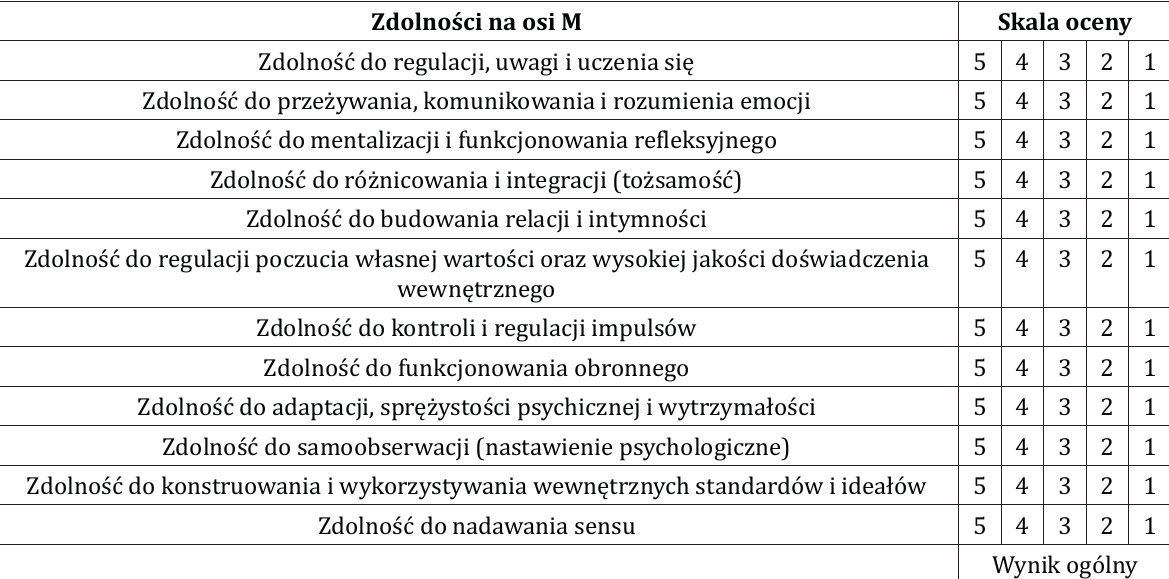
Tabela 2. Ocena zdolności na osi M (źródło: [3]) Zdolności na osi M Skala oceny